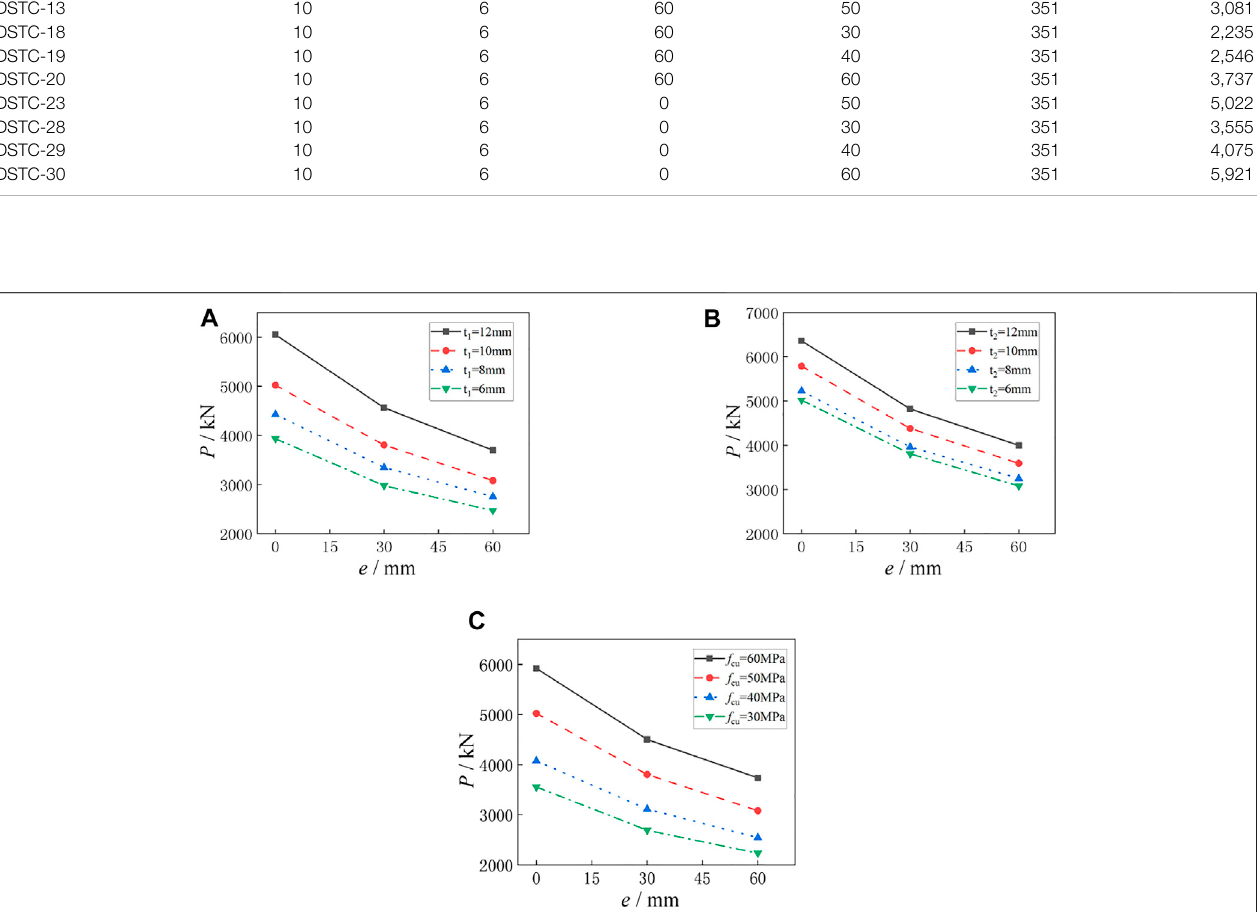
Frontiers in Materials |